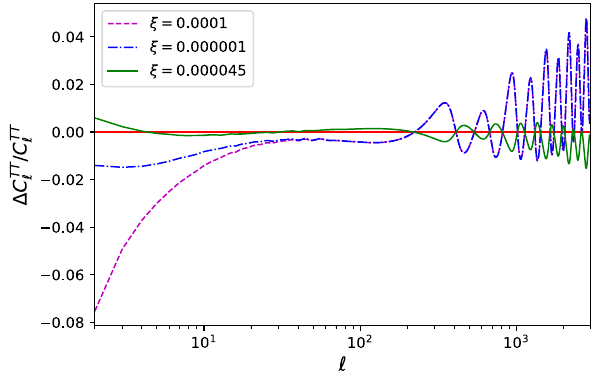
Fig. 3 Relative deviation of CMB TT power spectrum from the base line Planck 2015 (cid:3) CDM model (red line) for various values of ξ while the other parameters are fixed to their best-fit mean values as given in Table